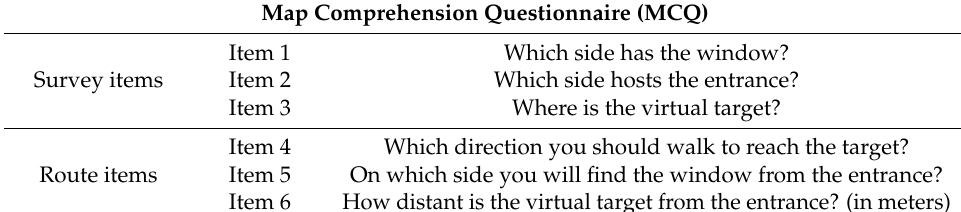
Table 2. Map comprehension questionnaire. Items 1–3 are survey items because they required an allocentric answer (e.g., North, East, South-West, etc.). Items 4–6 are route items because they required an egocentric answer (e.g., right, left, ahead, etc.). Map Comprehension Questionnaire